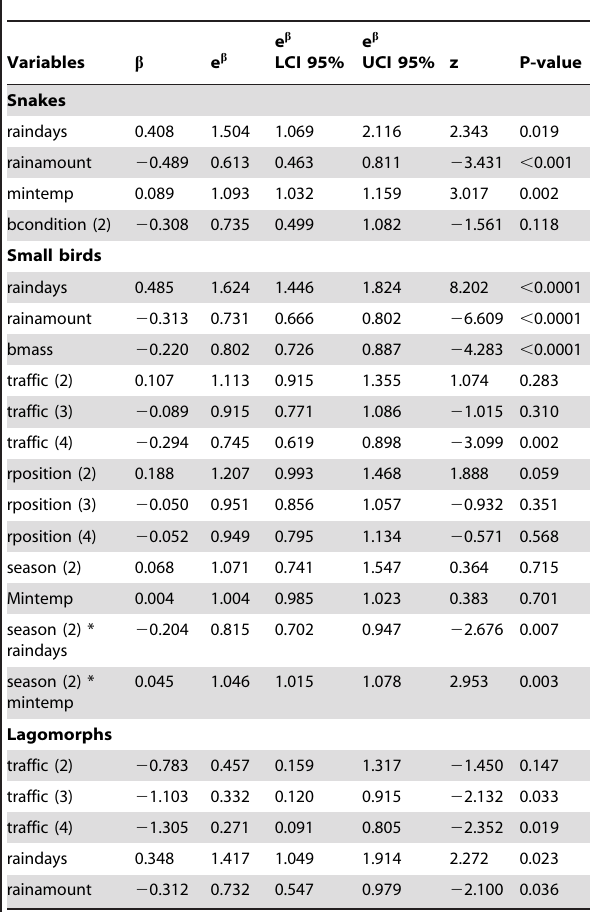
Table 4. Multivariate Cox hazards models for Bats, Toads, Salamanders, and Small mammals ( b : coefficients, e b : hazards ratio, e b LCI 95%: 95% lower confidence interval for hazards ratio, e b UCI 95%: 95% upper confidence interval for hazards ratio, z: Wald test, P-value: significance of Wald test, for variables definition, see table 8).